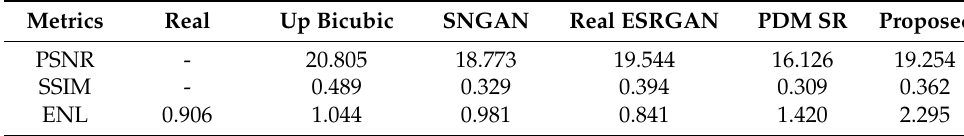
Table 2. Valuation results of synthetic SAR images dataset.